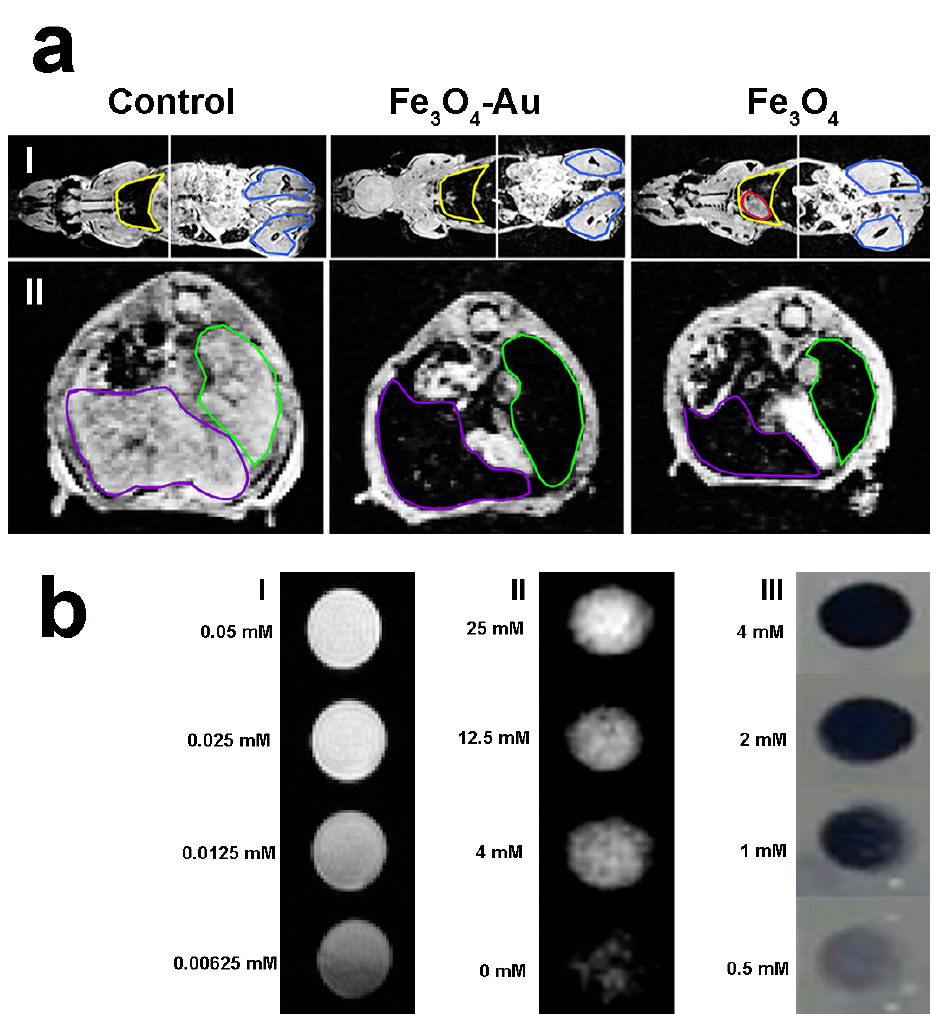
Figure 11. Performance of heterodimers in bioimaging applications. MRI images of the mouse tissues 24 h after injection of Fe 3 O 4 and Fe 3 O 4 -Au contrast agents from two sections, ( I ) first section scan of ling (yellow), muscle (blue), and heart (red), ( II ) sectional plane (white stripe in ( I )) of liver (purple) and spleen (green). Reproduced with permission from [108], copyright (2015) Elsevier ( a ), Multimodal imaging with contrast agents of Fe 3 O 4 -Au heterodimers with different concentrations for ( I ): MRI, ( II ): CT, and ( III ): PA techniques ( b ). Reproduced with permission from [109], copyright (2017) Royal Society of Chemistry.